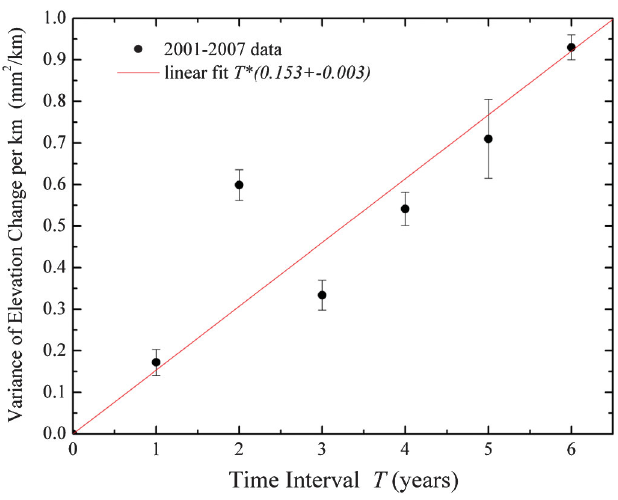
FIG. 19. (Color) Variances of the Tevatron alignment rod dis- placements per unit distance vs the time interval between the measurements (see text, from Ref.